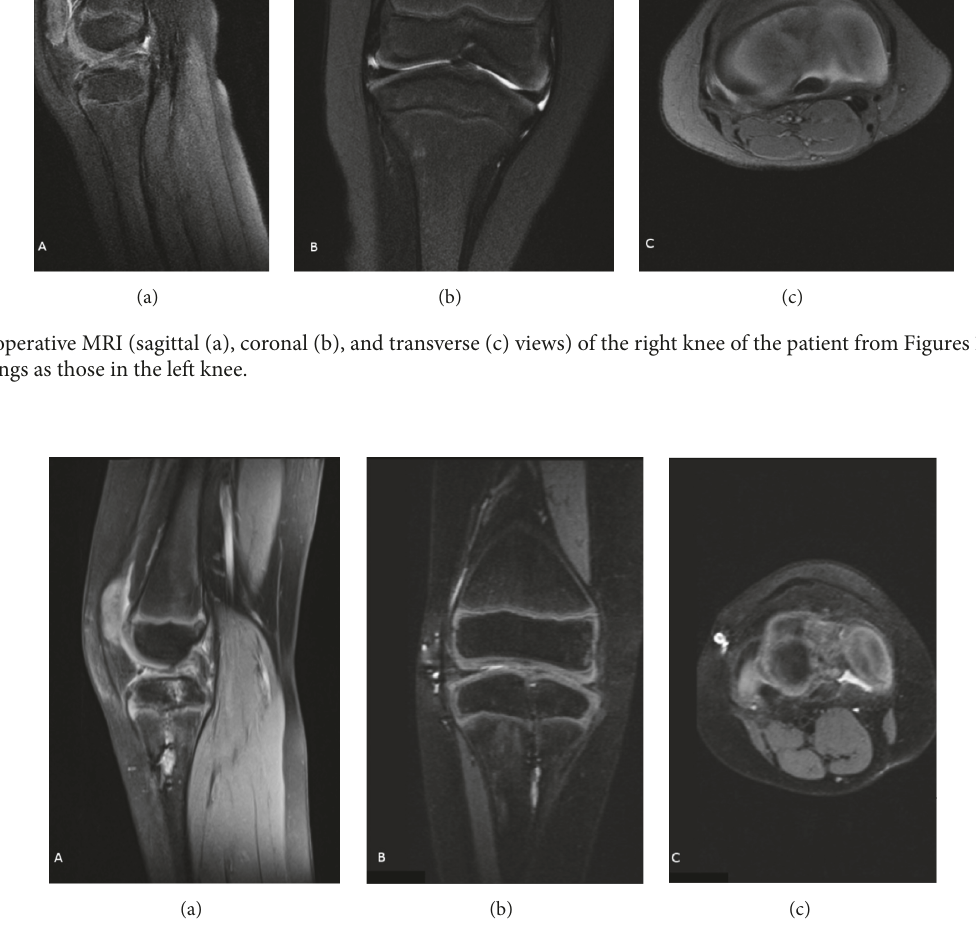
Figure 4: Postoperative MRI (sagittal (a), coronal (b), and transverse (c) views) of the left knee of the patient from Figures 1–3. Graft integrity was